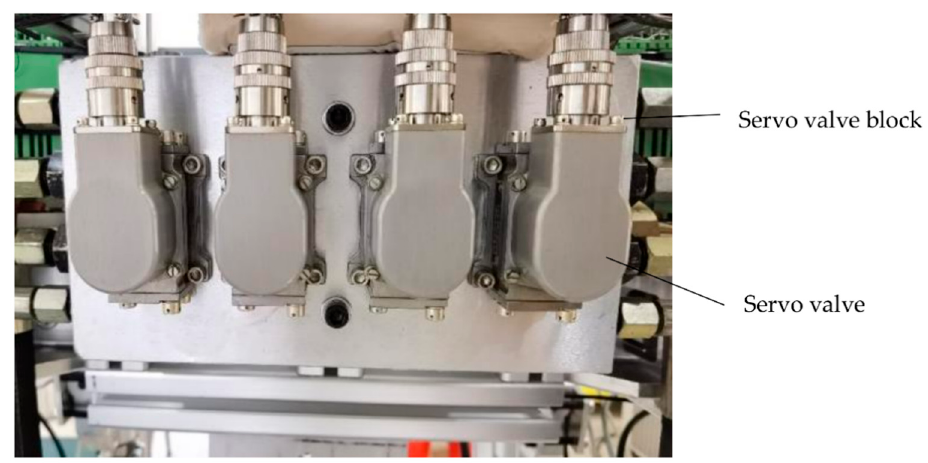
Figure 12. Knee hydraulic cylinder.